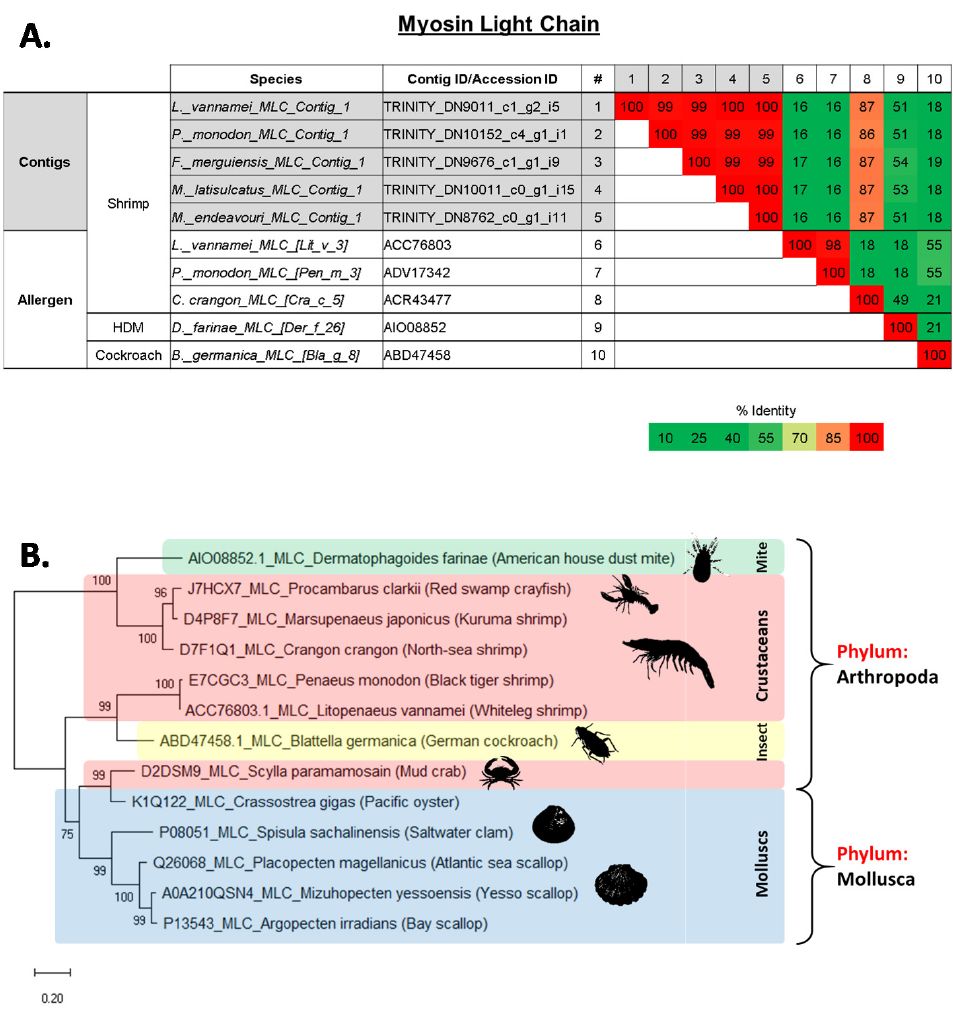
Figure 5. ( A ) Comparison of amino acid sequence identities of (1–5) contigs from five shrimp species that matched with myosin light chain (MLC) allergens, (6–8) known shrimp MLC allergens and (9–10) house dust mite and cockroach MLC allergens. The sequence identities were calculated using multiple sequence alignment in Clustal Omega (EMBL-EBI). ( B ) Molecular phylogenetic tree based on published amino acid sequences of Myosin light chain (MLC) from edible crustacean and mollusc species, and allergy causing mite and insect species. The branches consist of UniProt ID/Genbank Accession ID, species name, followed by common name in brackets. The numbers next to the branches indicate the bootstrap test percentage of 10,000 replicate trees.